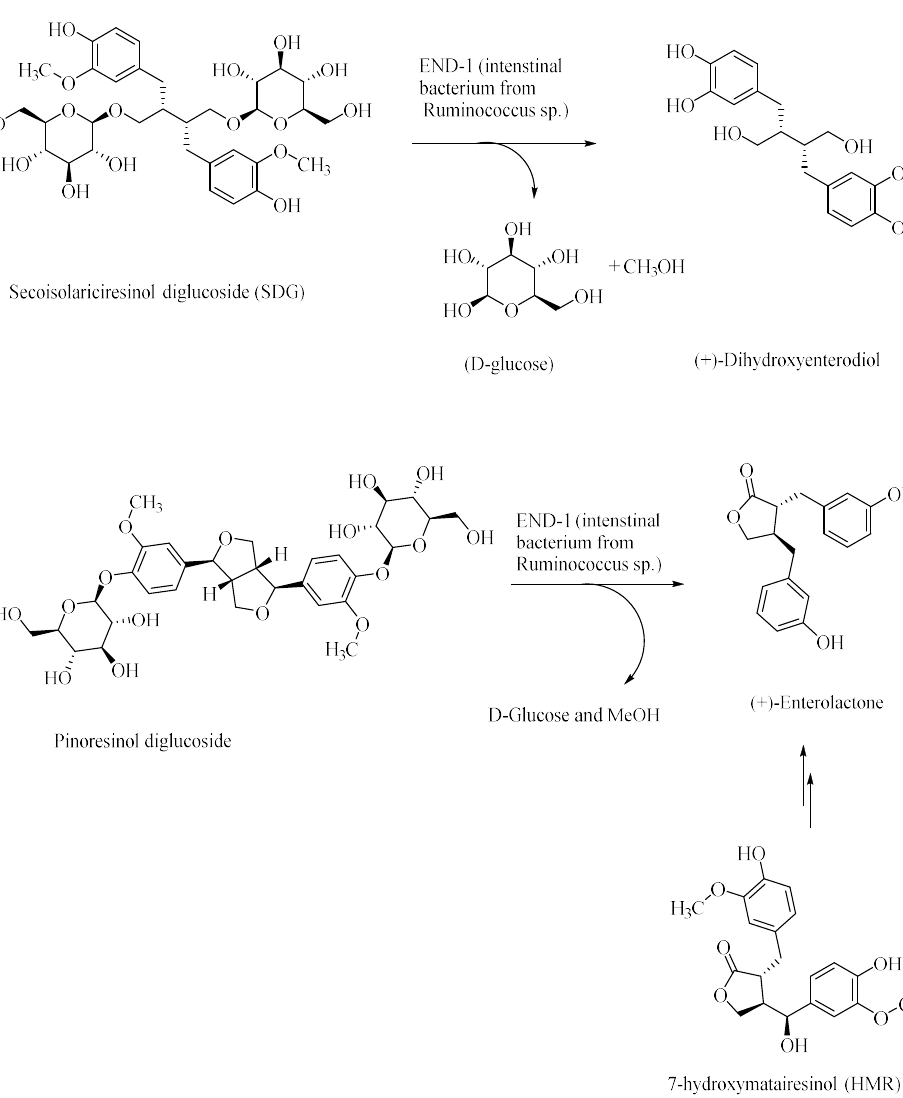
Figure 4. Gut bacteria in the transformation of plant-based lignans to human lignans— dihydroxyenterodiol and